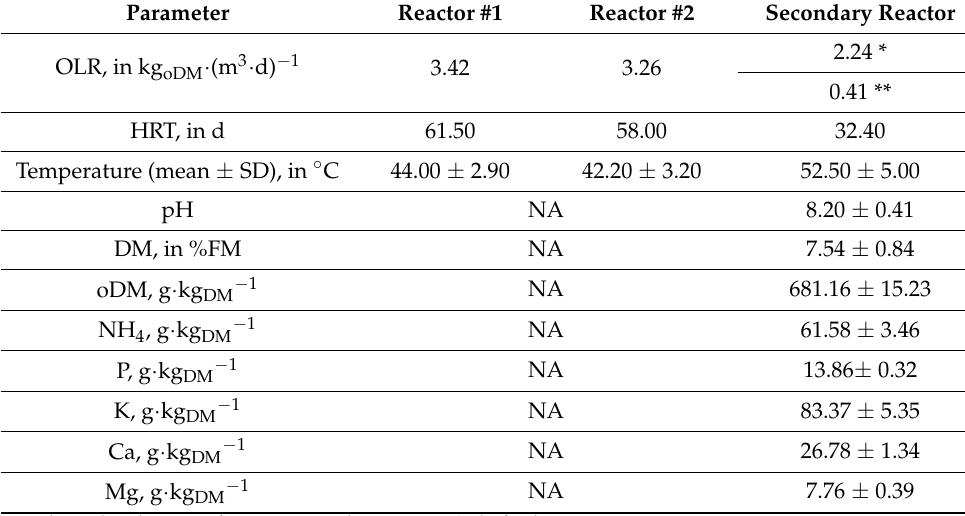
Table 2. Operating conditions of the research biogas plant “Unterer Lindenhof” and the properties of the digestate during the experimental period. OLR: organic leading rate; HRT: hydraulic retention time; FM: fresh matter; NA: not available. Parameter Reactor #1 Reactor